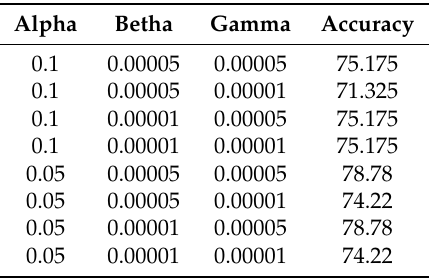
Table 2. FNGLVQ Setup parameters.